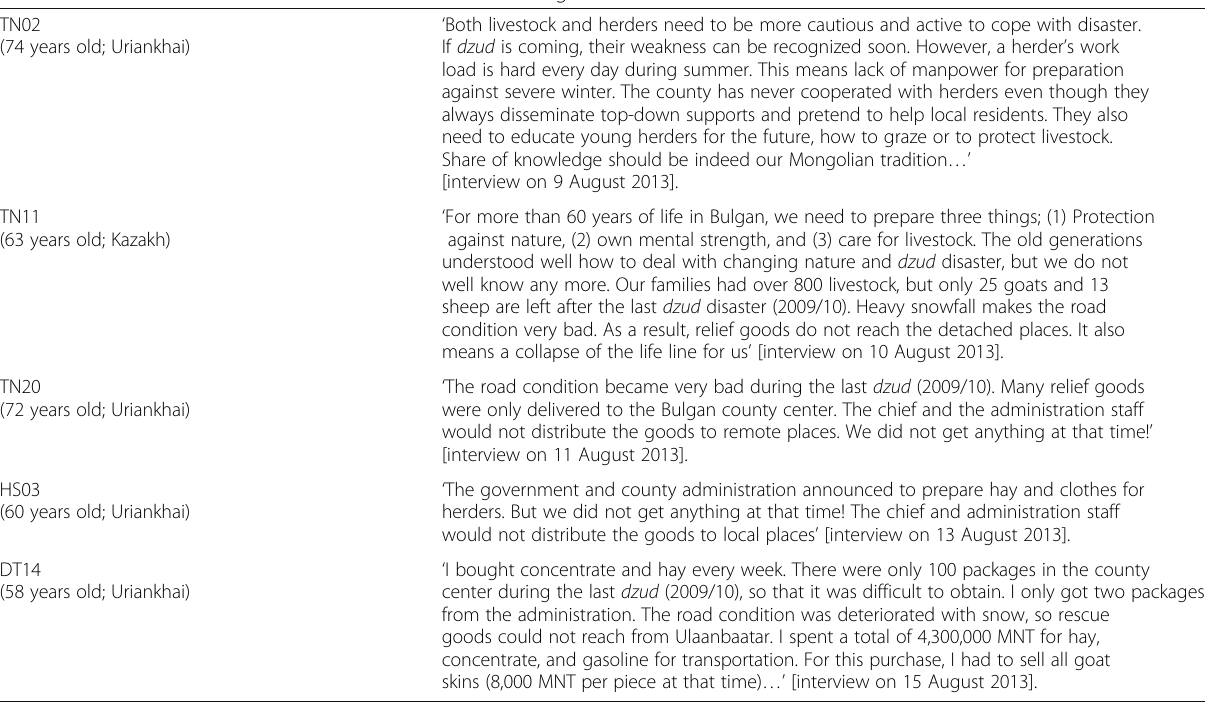
Table 5 Notable comments of individual local elders concerning lessons learned from the 2009/10 dzud and possible measures that in the future could reduce disastrous dzud effects in the Mongolian